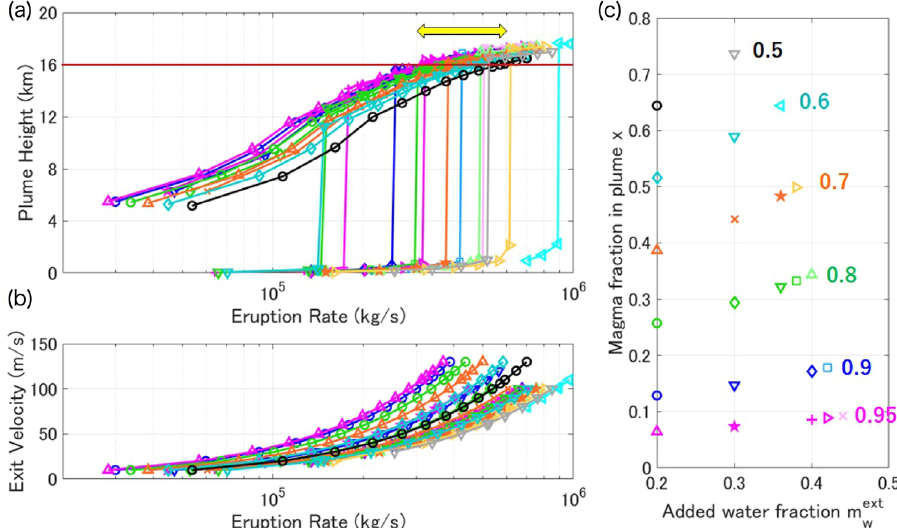
Fig. 4 The relationships between plume heights, eruption rates, and source conditions for the 2021 FOB eruption. a The relation between eruption rate (total magma discharge rate) M e and plume height H p . b The relation between eruption rates and given exit velocities. Exit diameter was fi xed at 100 m for all cases. The water mass fraction ( m w ) varies from 0.5 to 0.95 as the colours and numbers in c indicate (black: 0.5, light blue: 0.6, orange: 0.7, green: 0.8, blue: 0.9, and magenta: 0.95). The marker types are common among all of a – c , indicating the values of added water fraction ð m ext w Þ as shown on the horizontal axis of c . The relatively light-coloured cases did not yield 16 km high plumes. The plume height of 16 km is achieved with M e of 3 – 6 × 10 5 kg/s (the yellow arrow in a